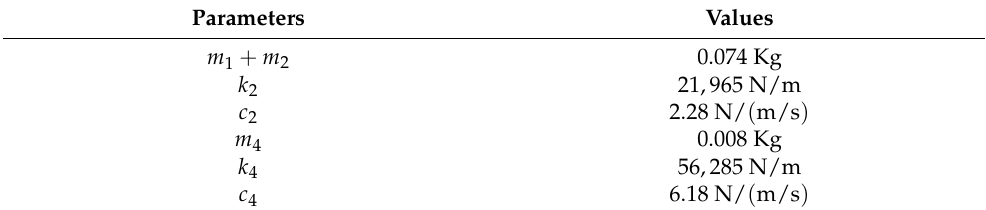
Table 1. Identified parameters of the developed positioning system.